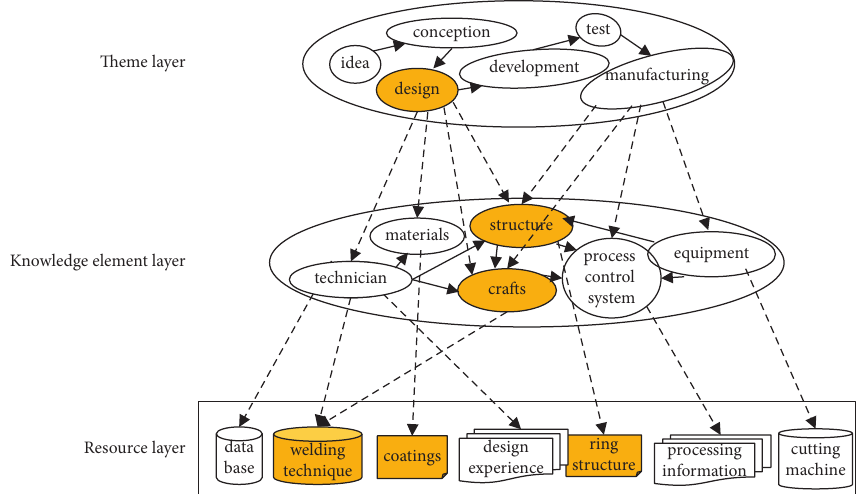
Figure 6: The knowledge map of WJ5E’s R&D.